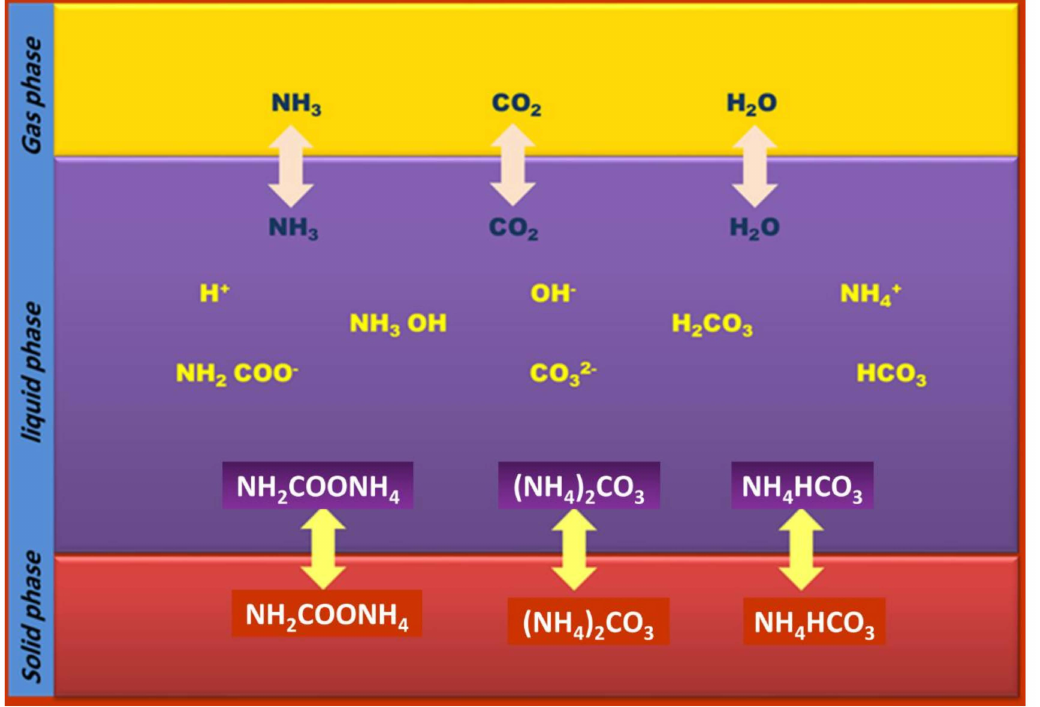
Figure 8. Three phase system for the chemical species leading to CO 2 absorption using aqueous ammonia [149], reproduced with permission No.